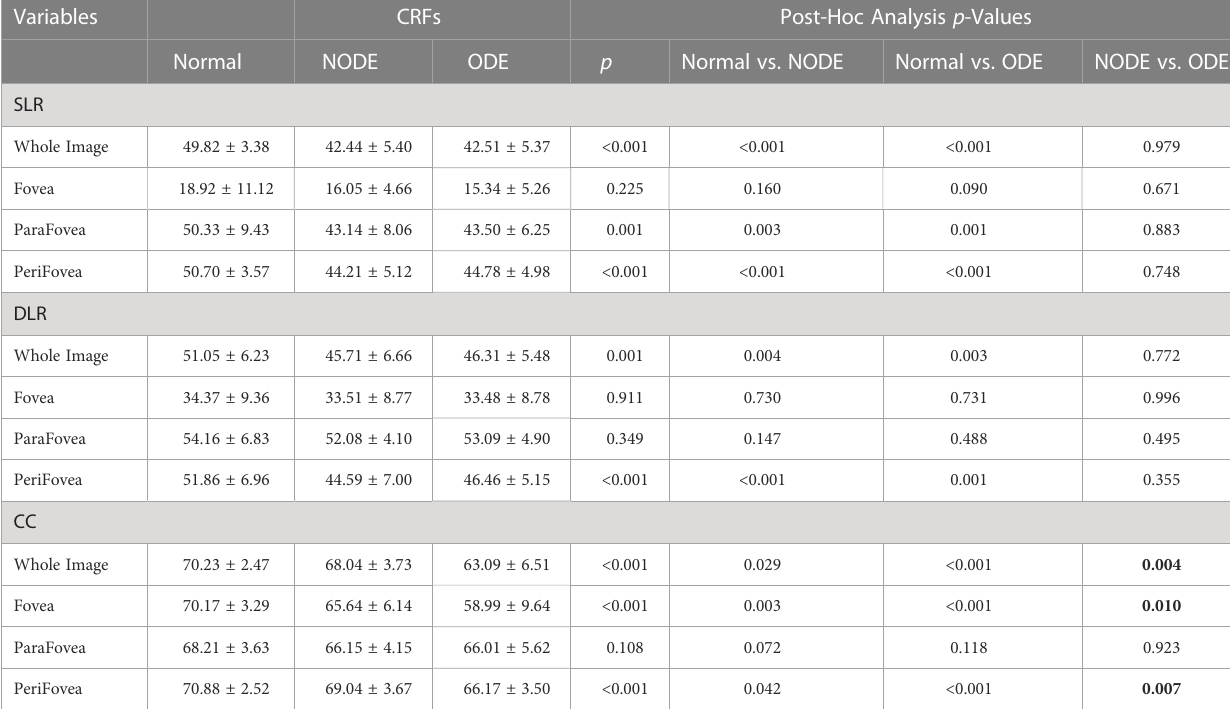
TABLE 3 The comparisons of macular retinal and choroidal microvascular density. Variables CRFs Post-Hoc Analysis p -Values